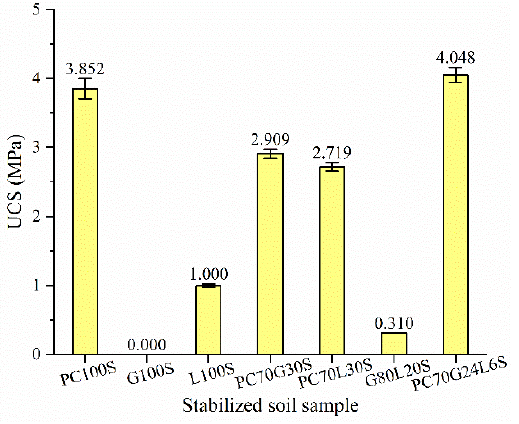
Figure 2. Unconfined compressive strength (UCS) of the stabilized soil samples.